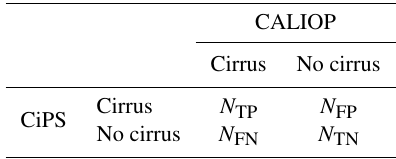
Table 2. Contingency table for the cirrus detection from CALIOP and